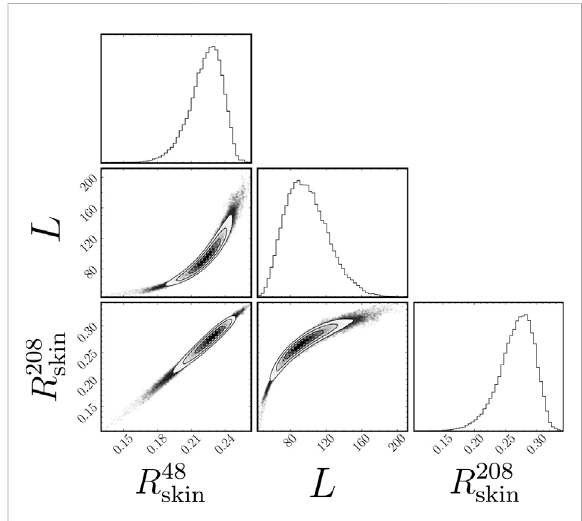
FIGURE 7 Correlation corner plot [81] between the posterior distributionsfortheneutronskinof 48 Caand 208 Pb(bothinfm),and the slope of the symmetry energy L (in MeV). A total of 100,000 samples from the 5,000,000 visited parameter values were used to make these distributions. Both neutron skins R 48 skin and R 208 skin are strongly correlated, each with negative skewness. The distribution for L , on the other hand, has a positive skewness and, while it is strongly correlated with both neutron skins, the correlation displays a non-linear behavior in both